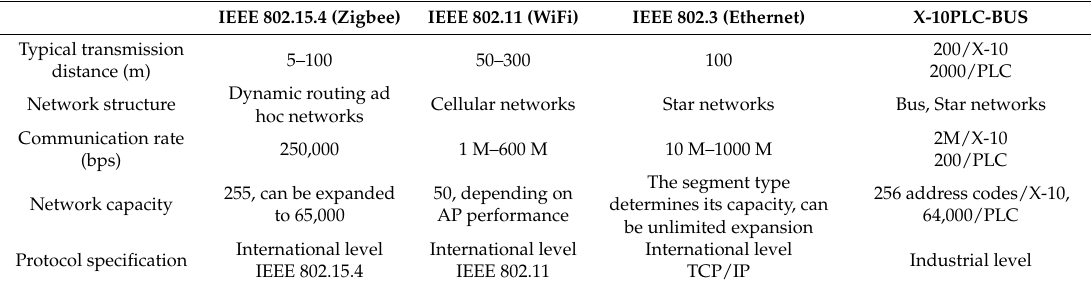
Table 1. Comparison of typical communication methods in smart home.